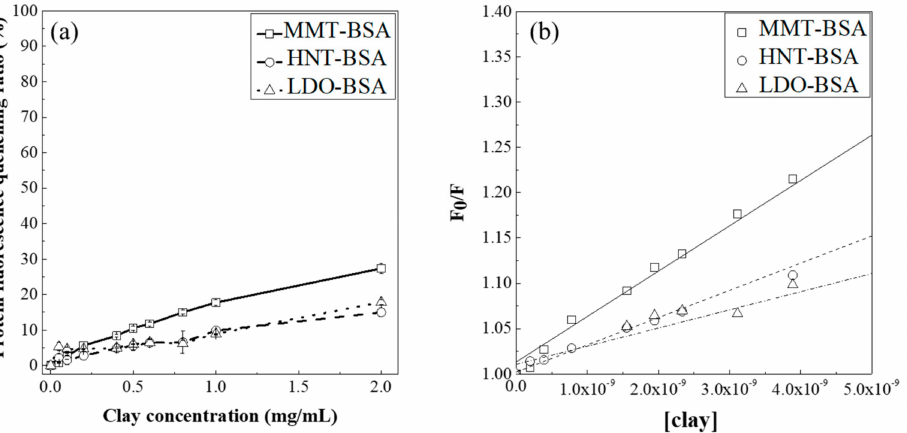
Figure 5. ( a ) The protein fluorescence quenching ratio depending on the clay’s concentration, ( b ) fitting of the quenching data to the Stern–Volmer